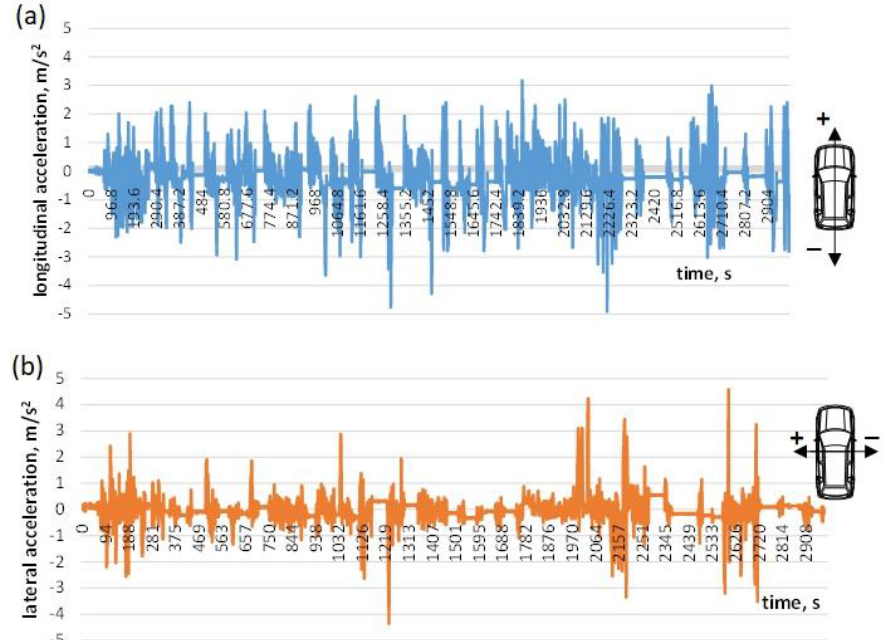
Figure 4. The examples of recorded values of the vehicle acceleration: ( a ) longitudinal; ( b ) lateral.